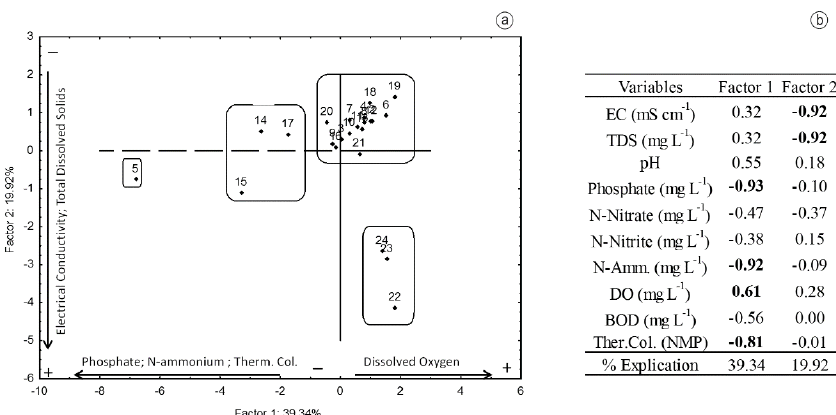
Figure 3. Principal Components Analysis of the sampling points of the Apodi/Mossoró river hydrographic basin, in the month of August of 2007. a) Representation of the two first PCA components; b) Variables correlation values. EC: Electric Conductivity; TDS: Total dissolved solids; N-Amm.: Ammoniacal nitrogen; DO: Dissolved oxygen; BOD: Biochemical Oxygen Demand; Ther.Col.: Thermotolerant Coliforms.